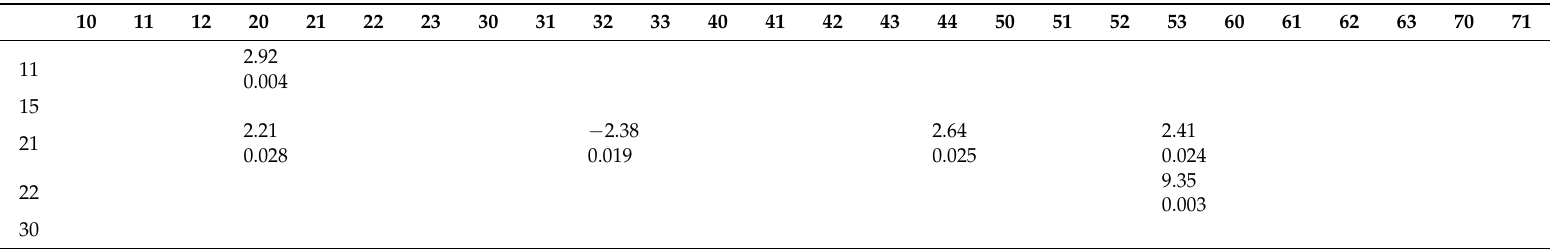
Table 5. Significant differences of DD vs. NSRD in reading time according to the reading mode (by columns) compared to the words difficulty (by rows). The rows name indicates: the first digit, the number of syllables of the word and the second digit, the number of grammatical difficulties. By columns: 11: Flash-correct; 15: Flash-incorrect; 21: sustained correct; 22: sustained incorrect; 30: non-read. The non-zero cells contain the t-test value above and the P value below. The reading time of the DD children was in general higher than NSRD, except for the combination of